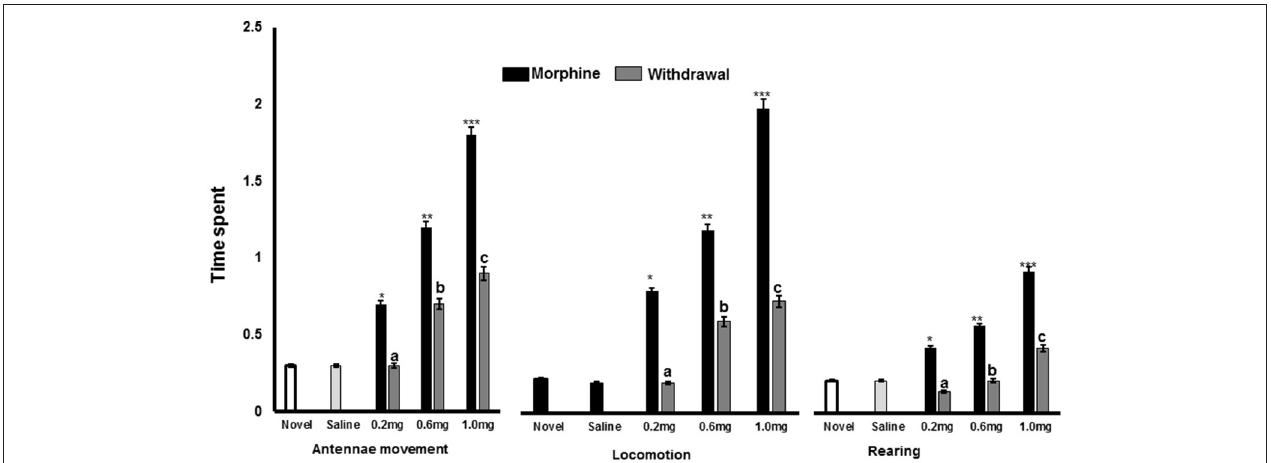
FIGURE 1 | Effects of repeated morphine injections for 5 days on crayfish exploratory behaviors. Results are presented as mean percentage of time. Post hoc analysis revealed differences for 0.2 mg/kg ( a P < 0.01), 0.6 mg/kg ( b P < 0.001), and 1.0 mg/kg ( c P < 0.0001) for antennae movements, locomotion, and rearing behaviors. Morphine injections increased antennae movements, locomotion and rearing behaviors for 0.2 mg/kg (* P < 0.01), 0.6 mg/kg (** P < 0.001), and 1.0 mg/kg (*** P < 0.0001) doses.